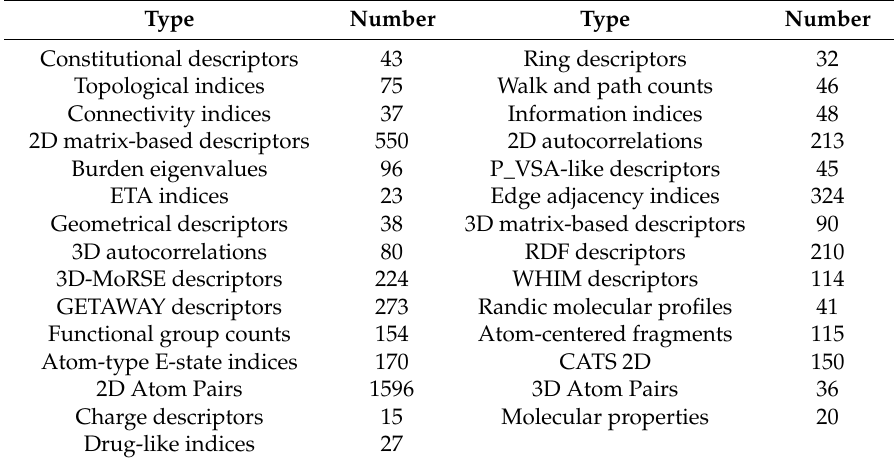
Table 1. The types and numbers of descriptors calculated by Dragon 6.0